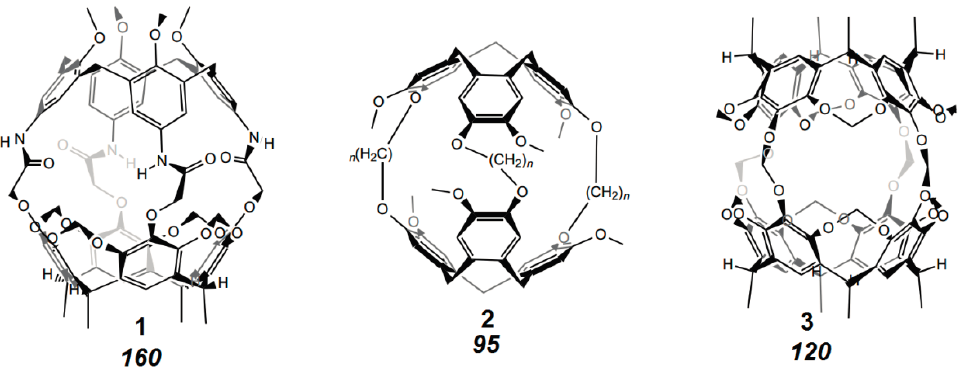
Figure 18. Calix[4]arene-carceplex 1 , cryptophane 2 ( n = 2), and carceplex 3 , with volume of the internal cavity, in [Å 3 ]